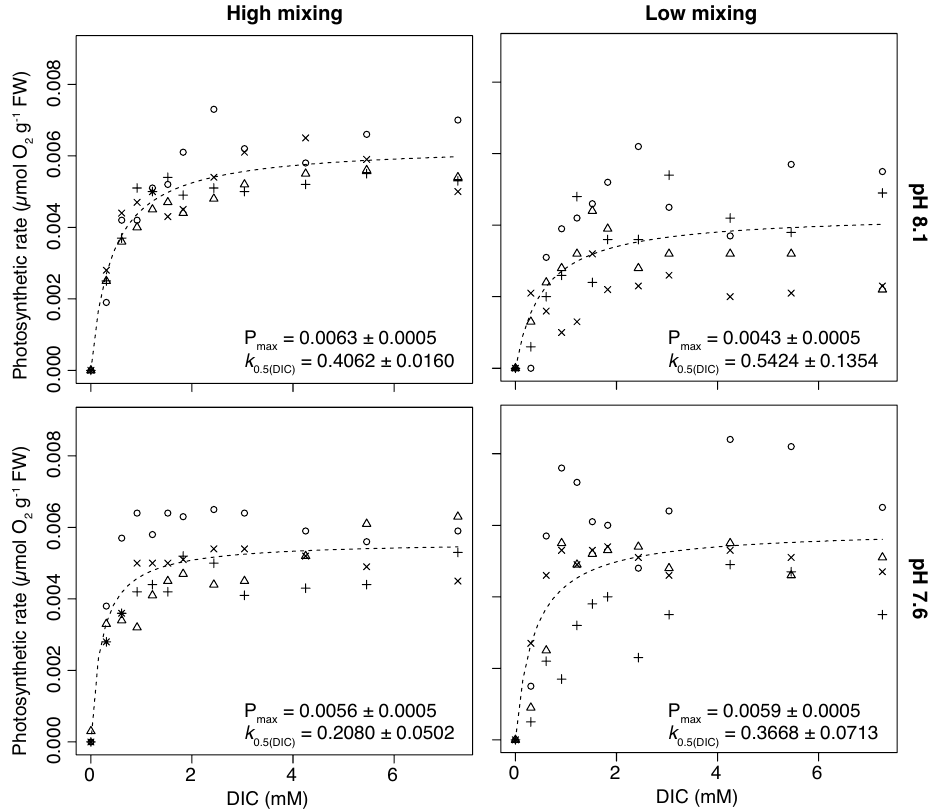
Figure 2. Photosynthetic rates (P) of Hymenena palmata (non-CCM) at increasing concentrations of DIC at high (left graphs) and low (right graphs) mixing treatments and at a pH of 8.1 (top graphs) and low pH of 7.6 (bottom graphs). Different shaped points represent the individual replicates (n = 4) with the dashed line P max ( [ DIC ] ) indicating the fitted Michaelis–Menten curve ( P = k 0.5 +[ DIC ] ) . Values of P max and k 0.5(DIC) listed on the figure are means ±